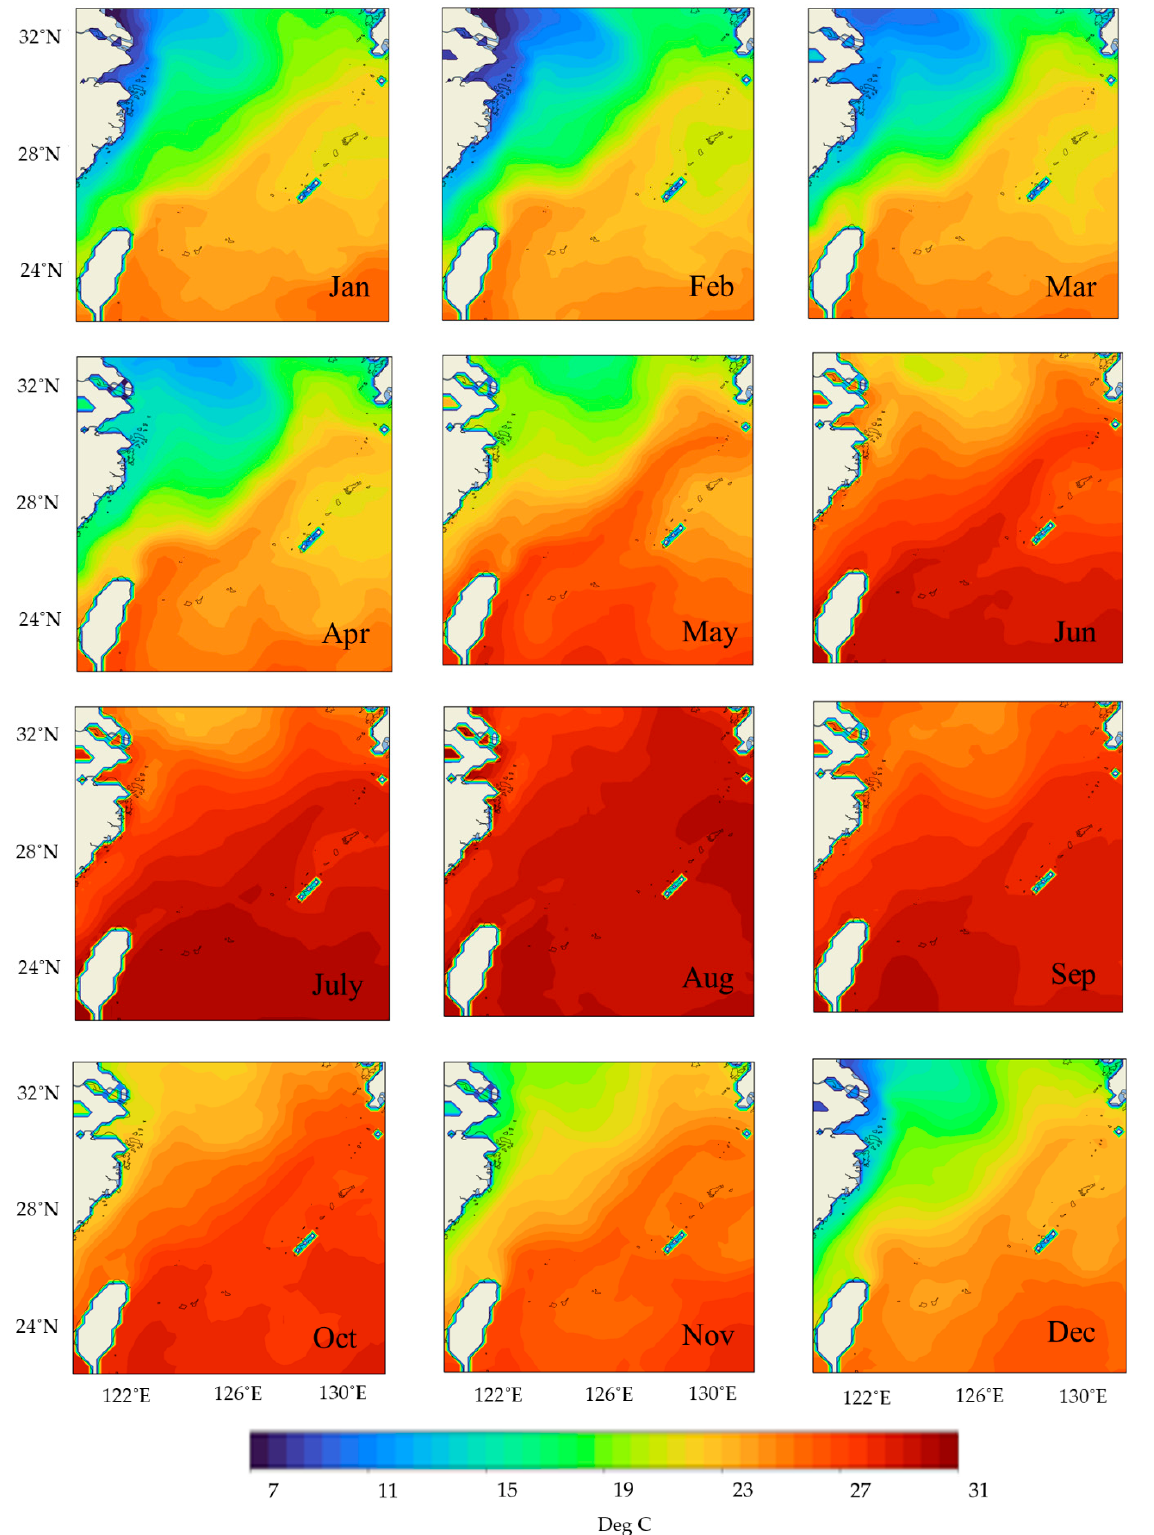
Figure 7. Spatial distribution of monthly mean sea surface temperature predicted by LSTM model in 2020, the unit of colorbar is degrees Celsius.